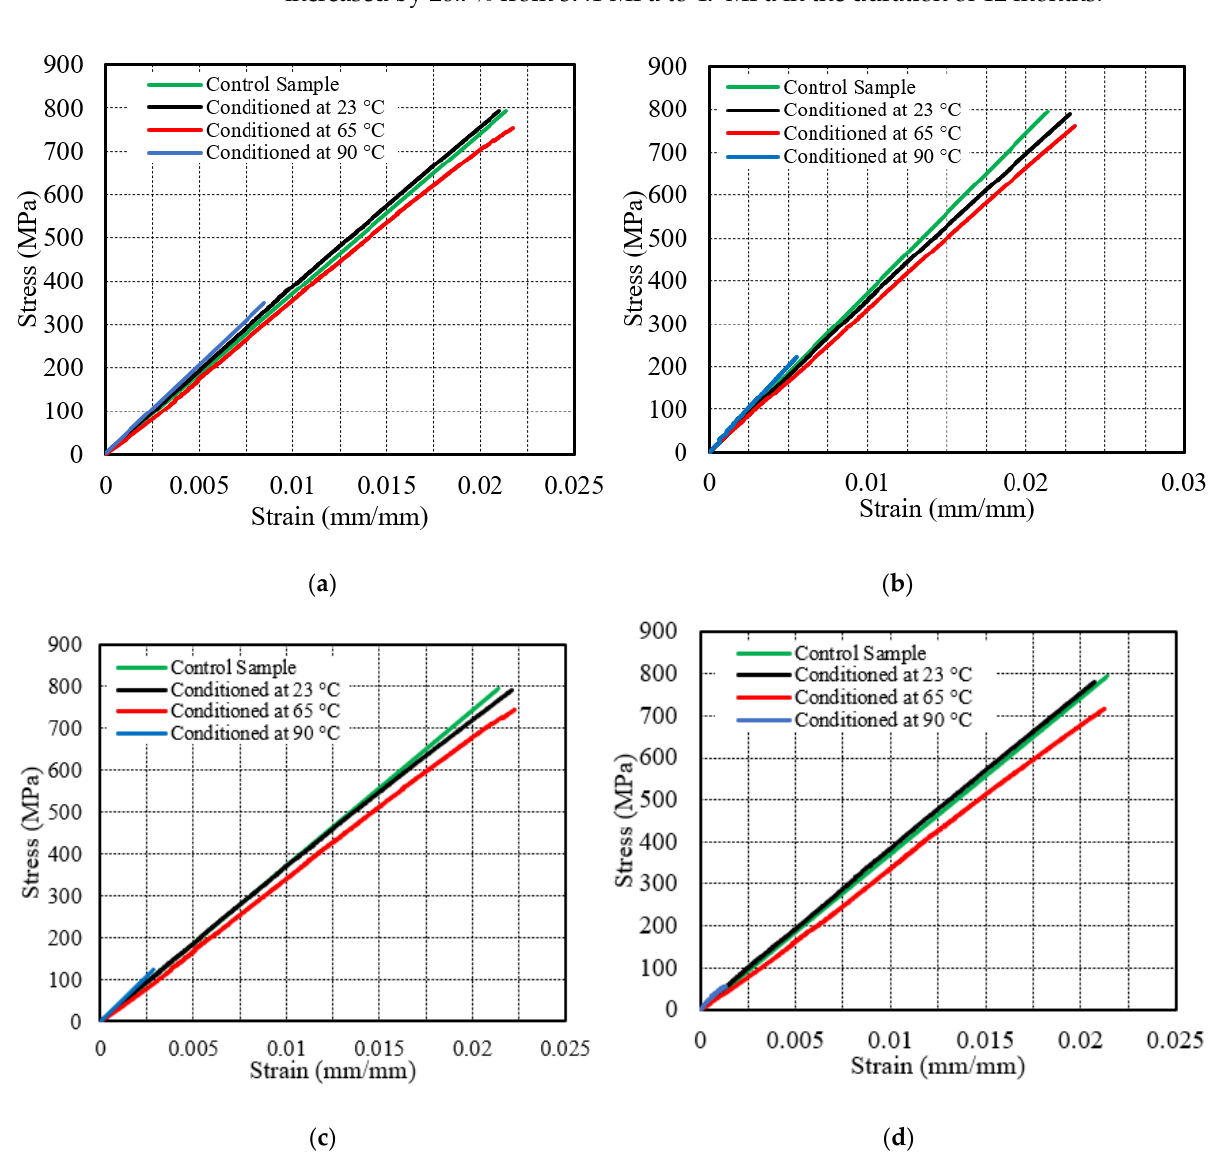
Figure 7. Stress–strain behavior of specimen immersed in seawater for ( a ) 3 months, ( b ) 6 months, ( c ) 9 months and ( d ) 12 months.